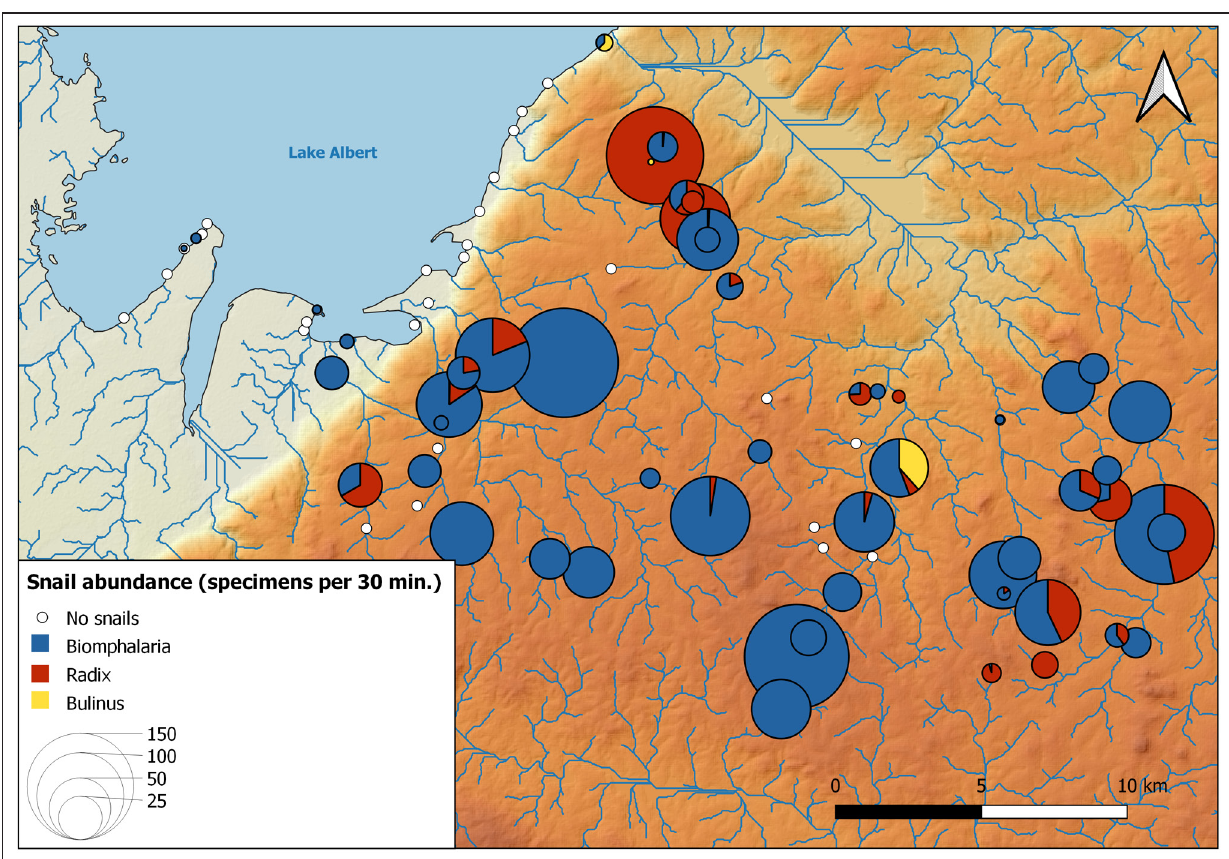
Figure 4 Map of the average reported abundances of snail species belonging to Biomphalaria , Radix , and Bulinus in March 2020. White circles mark sites where no species belonging to any of the three genera of interest were